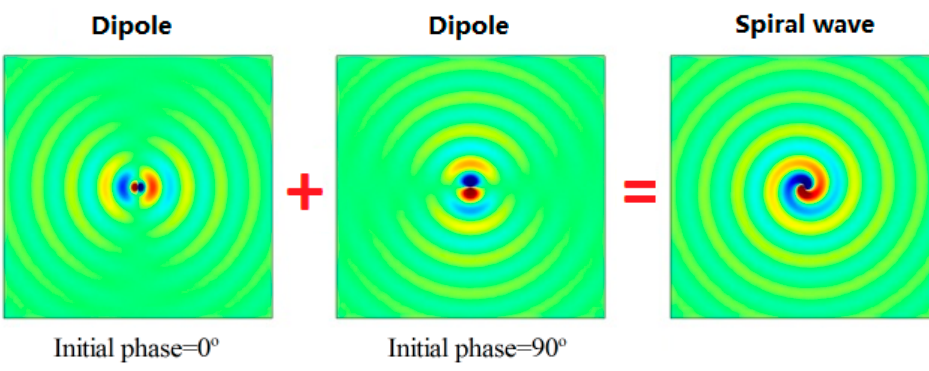
Figure 2. The spiral sound field generated by the superposition of two dipole sound fields.